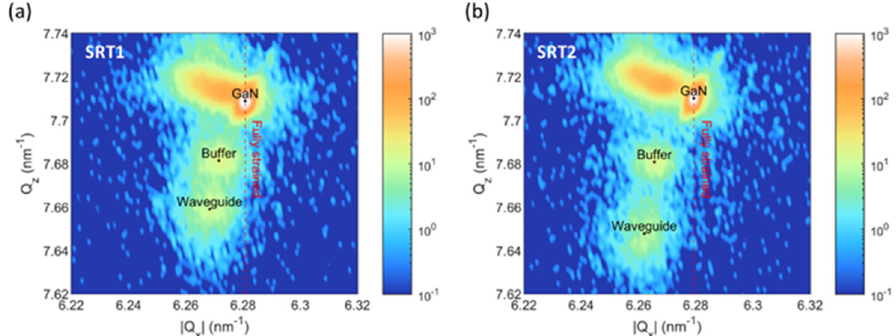
Figure 2. RSM results of ( a ) SRT1 and ( b ) SRT2 from HRXRD utilizing (cid:4666) 1 (cid:3364) 1 (cid:3364) 24 (cid:4667) off ‐ axis.